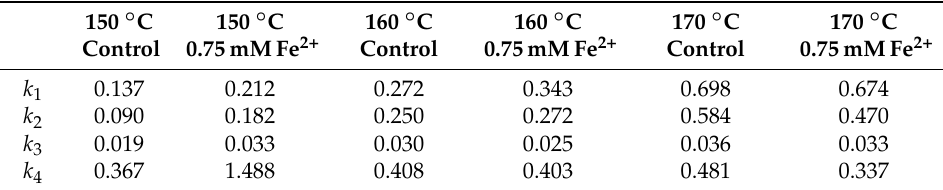
Table 2. Fitted kinetics constants to experimental data. The control refers to the acid-alone condition, as a comparison to the treatments in which 0.75 mM Fe 2+ is added to the acids.